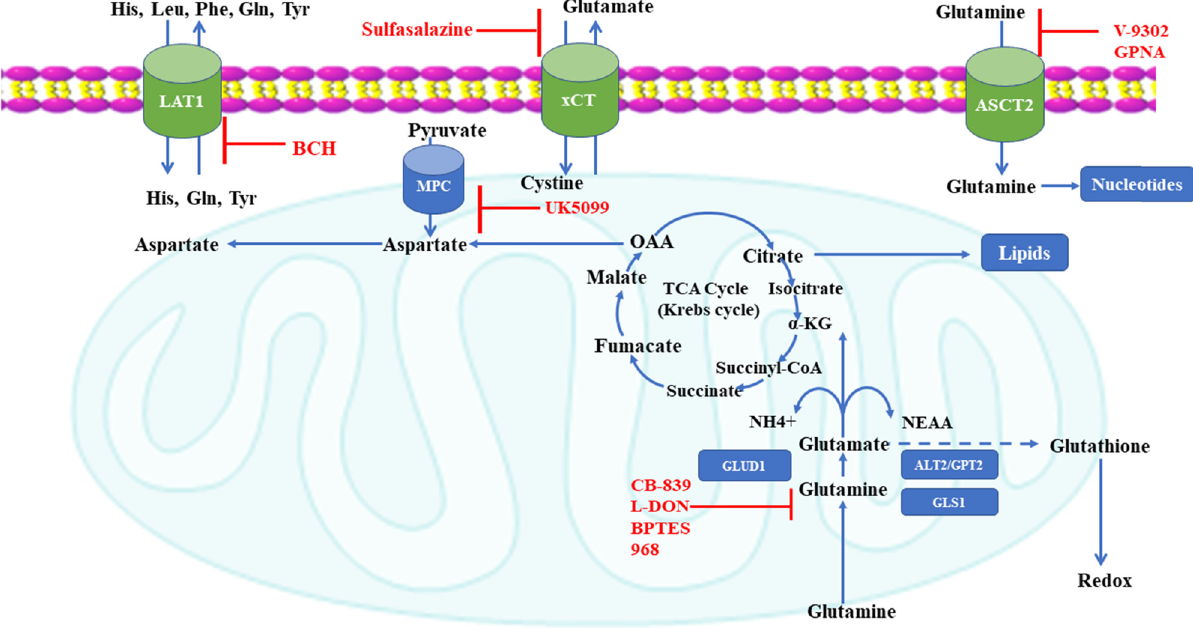
Figure 2: Mechanism of action of glutamine transporter. NEAA: non - essential amino acids; GLUD1: glutamate dehydrogenase 1; LAT2: alanine aminotransferase 2 recombinant protein; GPT2: glutamate pyruvic transaminase 2; TCA: cycle tricarboxylic acid cycle; and OAA: oxaloacetic